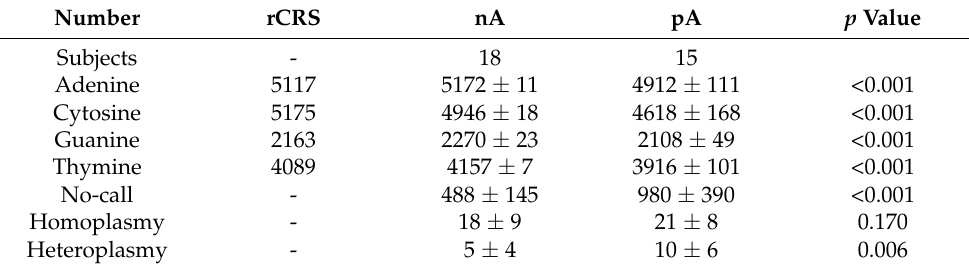
Table 2. Classic characteristics of mtDNA nucleotide sequences in normal and pathological aging.